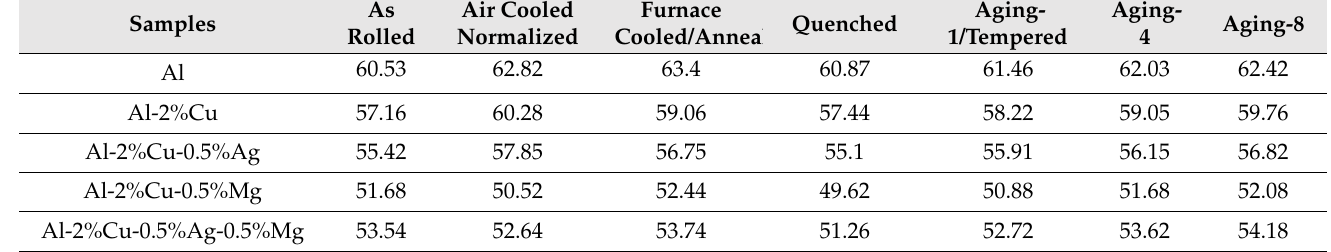
Table 4. Conductivity (%IACS) values of different heat-treated alloys.